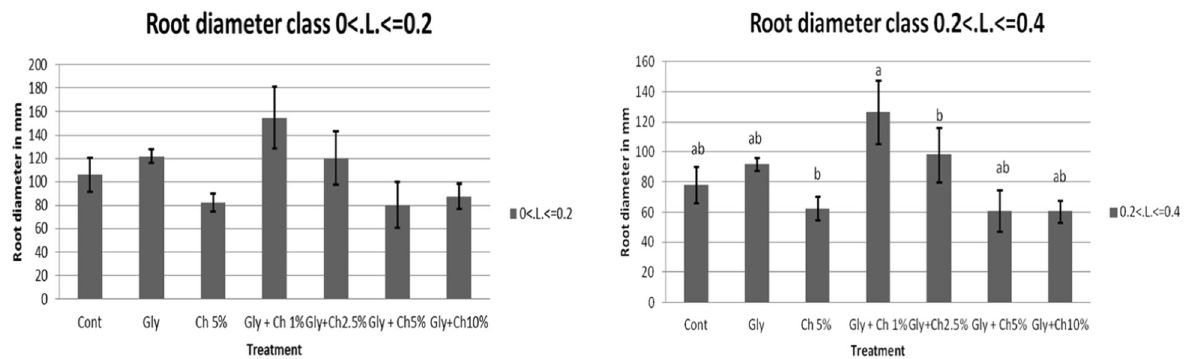
Fig. 5 Root length of winter wheat seedlings (cv. Isengrain) of different treatments 14 days after seeding in the diameter range 0.0 – 0.2 mm and 0.2 – 0.4 mm. Data show average treatment values of four independent replicates. Treatment letters were as follows: Cont = pure soil without glyphosate, Gly = glyphosate 6 L dose without biochar amendment, ch5% = biochar amendment of 5%, gly6L + ch1% = glyphosate with biochar amendment of 1%, Gly6L + ch2.5% = glyphosate with biochar amendment of 2.5%, Gly6L + ch5% = glyphosate with biochar amendment of 5%, and gly6L + ch10%= glyphosate with biochar amendment of 10%. Error bars indicating standard error. Different letters above the bars indicating significant differences ( α =